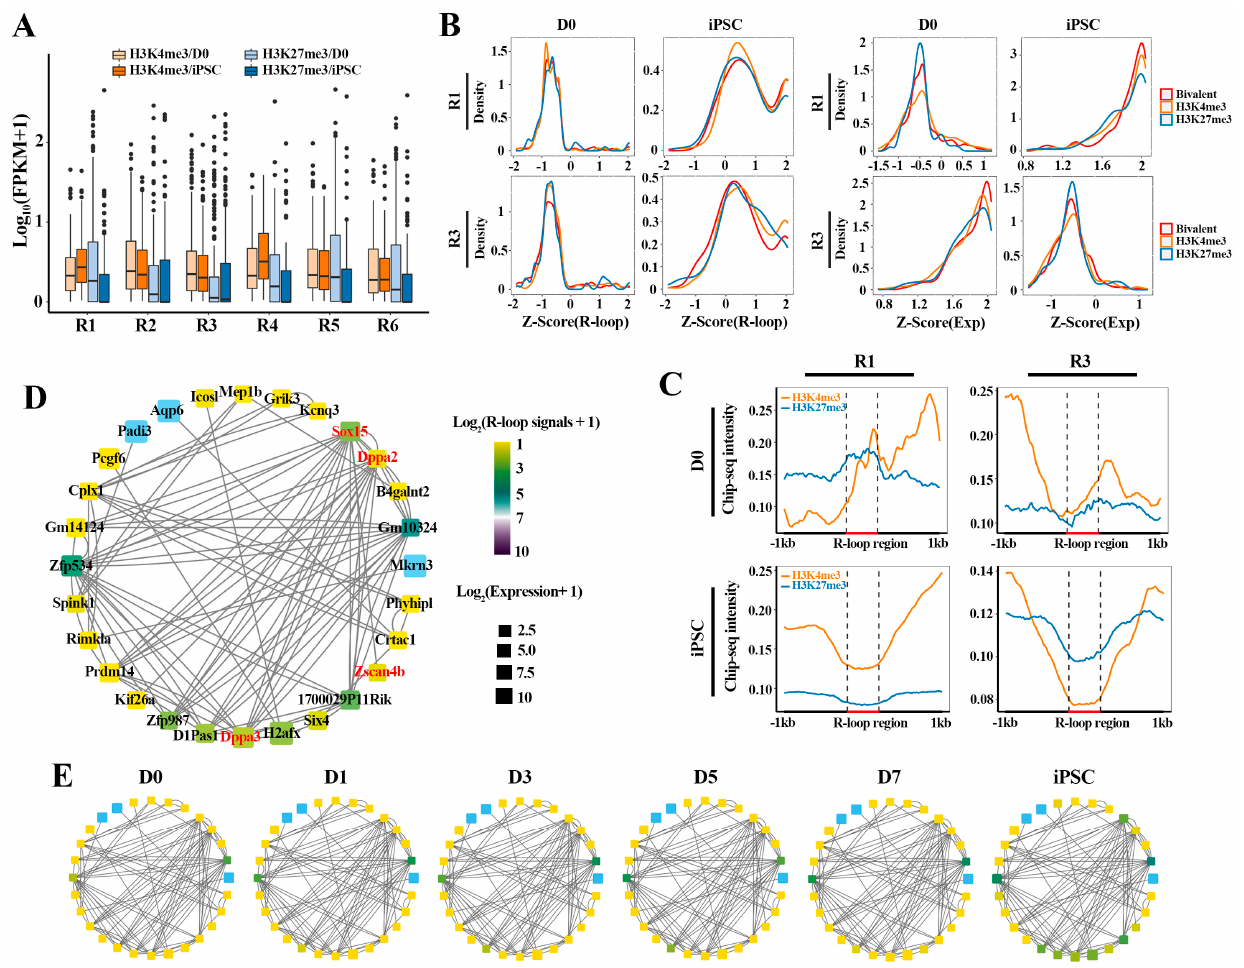
Figure 5. Dynamic transition of TRNs related to R-loops and HMs in reprogramming: ( A ) boxplot showing H3K4me3 and H3K27me3 binding signals (FPKM) on genes associated with bivalent histone modifications in D0 and iPSC; ( B ) the density distribution of R-loop signals (FPKM) and expression levels for genes (involved in R1 and R3, respectively) bound by H3K4me3, H3K27me3 and bivalent histone modifications; ( C ) average H3K4me3, H3K27me3 signals in 1 kb flanking R-loop regions for R1 ( n = 681) and R3 genes ( n = 651) at D0 and iPSC stages. These R-loops were located in promoter regions of genes; ( D , E ) dynamic transition of transcriptional networks from MEF (D0) to iPSC in R1. Color indicates R-loop signals and box size indicates gene expression levels. Genes symbols as shown in ( D ).